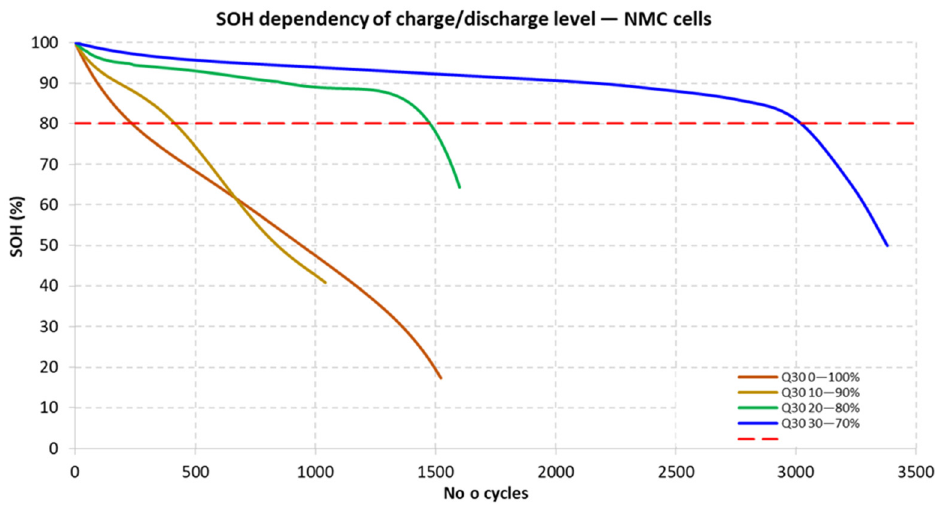
Figure 2. Loss of capacity of NMC Samsung INR18650–30Q cells as a function of the number of cycles for various operating ranges.